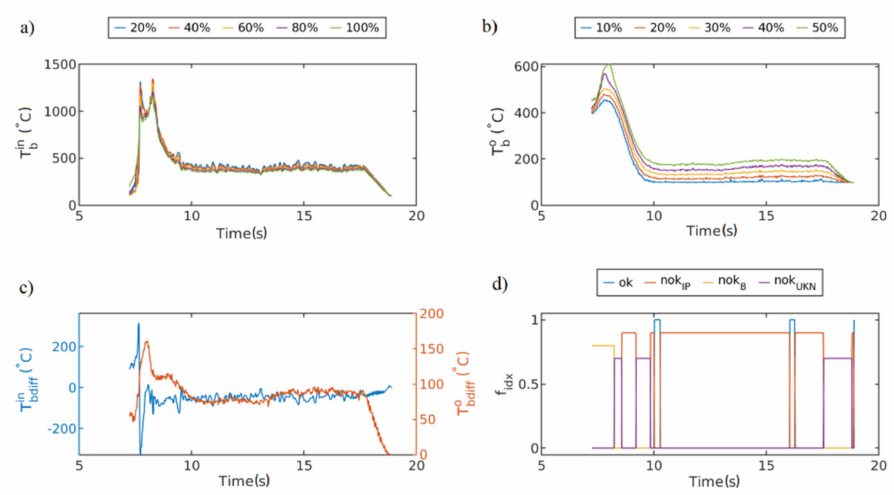
Figure 20. Feature and detection result for S19 using the original IR sequence: ( a ) inner band temperature distribution T in , ( b ) outer band temperature distribution T in b and T o , ( d ) weld defect detection result. bdif f